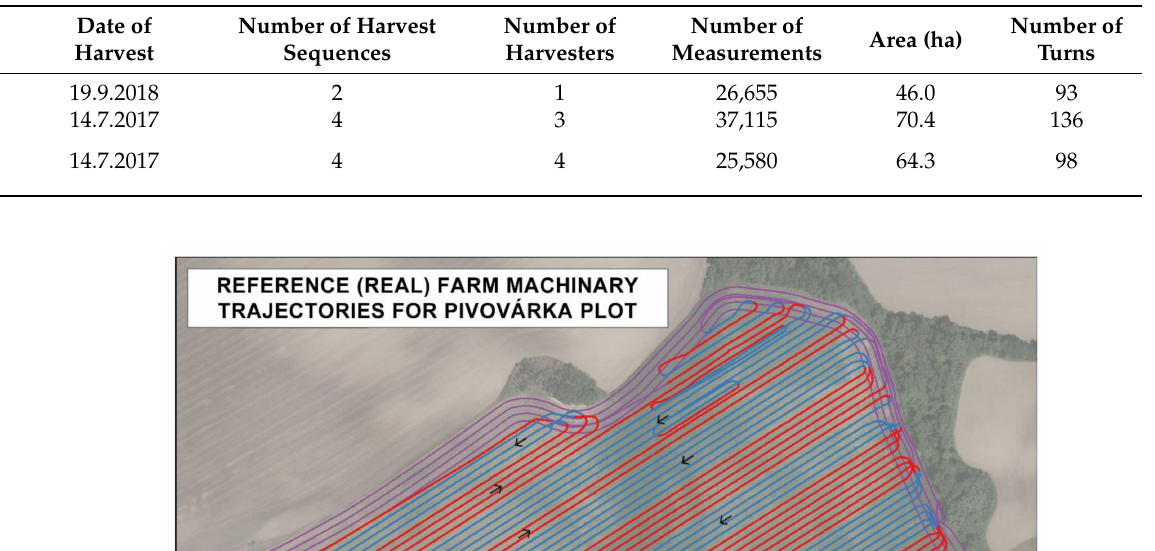
Table 1. Details of (real) reference farm trajectories measured at Rostˇenice Farm.